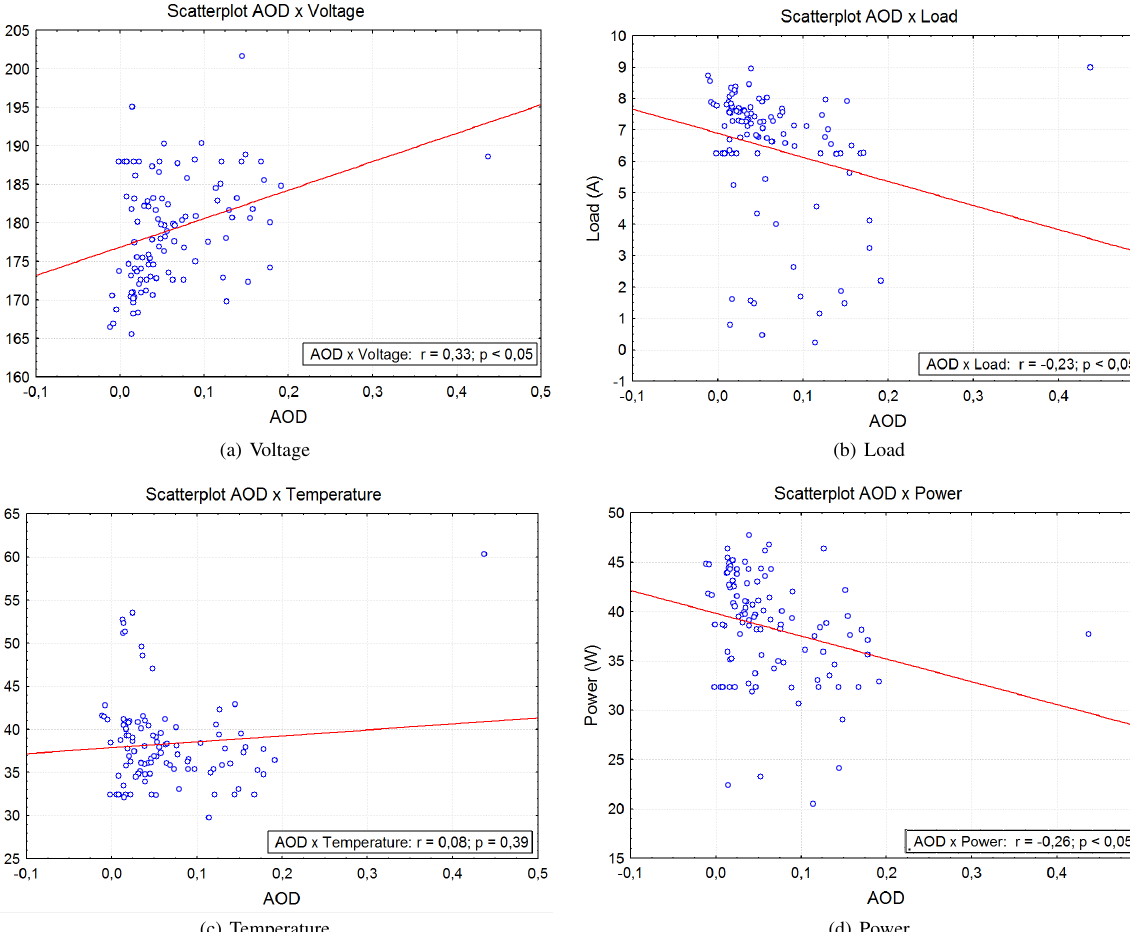
Figure 5. Power generation indicators correlation with